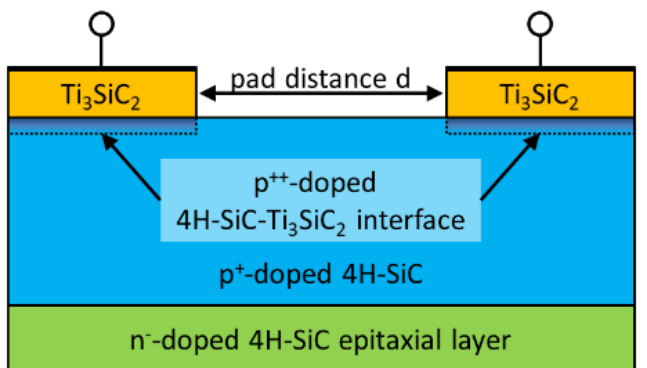
Figure 4. Scheme of the simulation model.